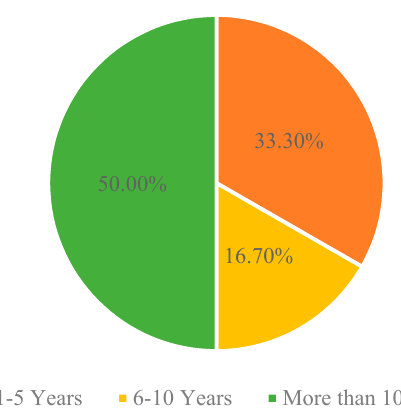
Figure 3. Respondents’ experience. Table 8. Risk evaluation